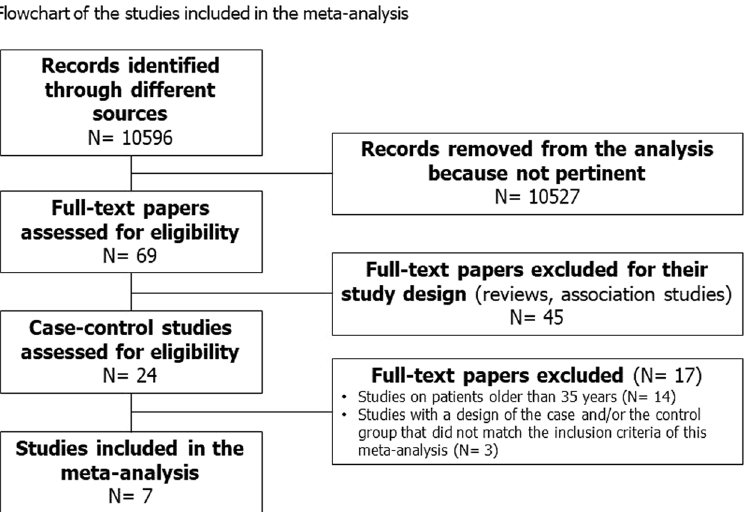
Figure 1. Flowchart of the studies included in the meta-analysis. We identified 10596 papers. 69 were assessed for eligibility. Based on the inclusion criteria of the present study, 7 were finally included in this